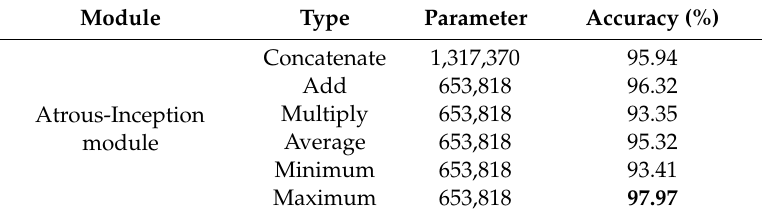
Table 5. The result of di ff erent layer merge methods of the Atrous-Inception module.